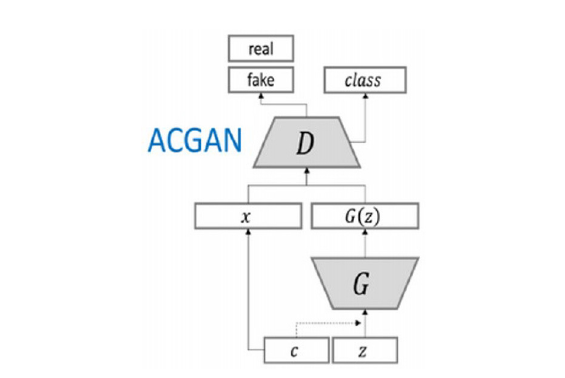
FIGURE2 AC-GAN architecture (figure is taken from Waheed et al., 2020). D is the discriminator, G is the generator, x represents the real image, c is the class label, and z is the noise vector.